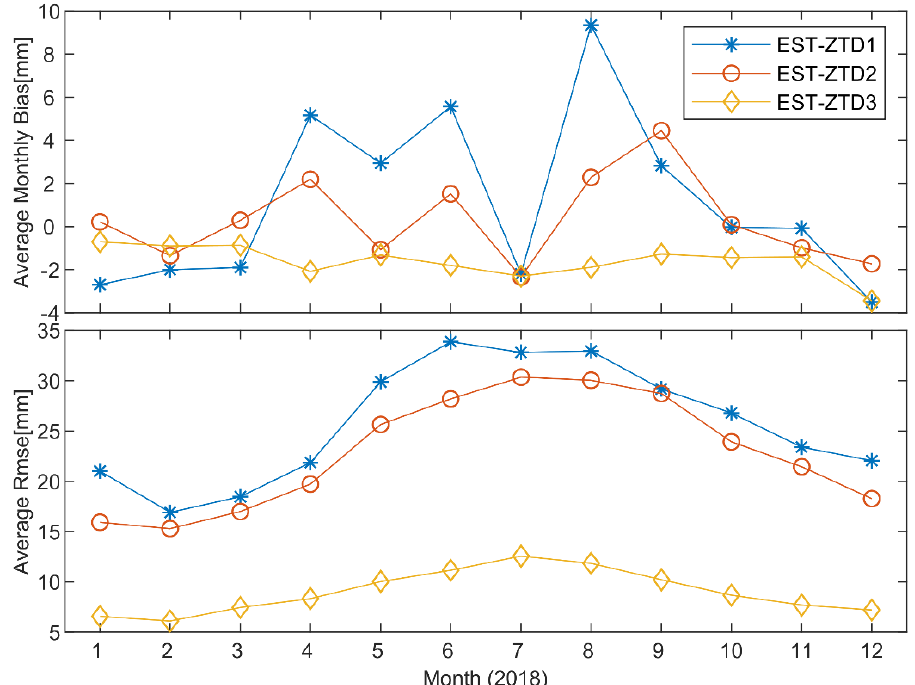
Figure 8. Average monthly bias and average RMSE of estimated ZTD values at 10 verifying IGS stations based on the three schemes.